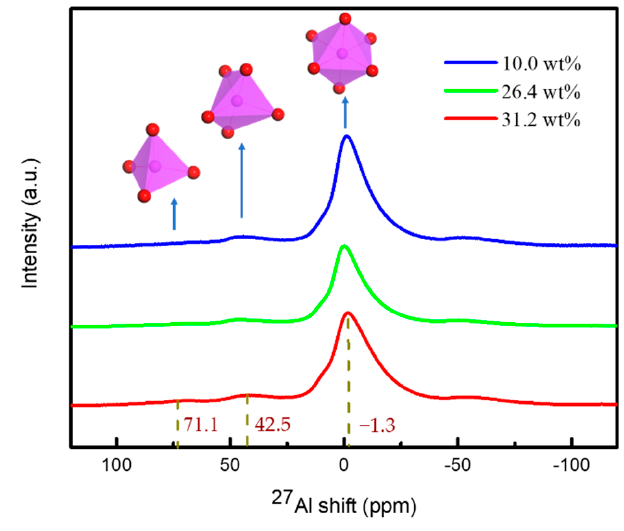
Figure 4. 27 Al NMR spectra of aluminum sols and gels.